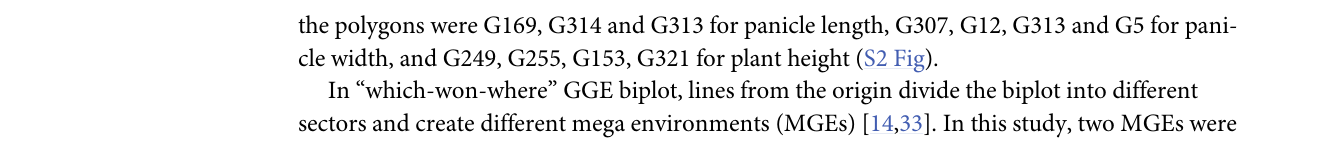
sectors and create different mega environments (MGEs) [14,33]. In this study, two MGEs were